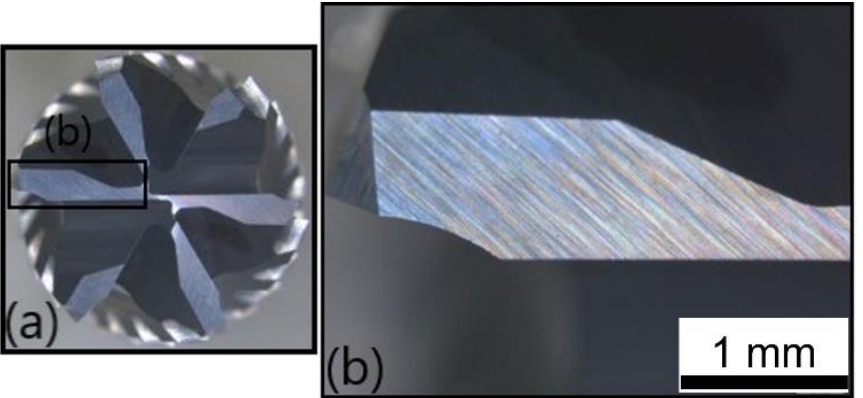
Figure 15. T2: Front view at the fresh state: ( a ) global view of the end-mill and ( b ) zoom on a top tooth clearance face.